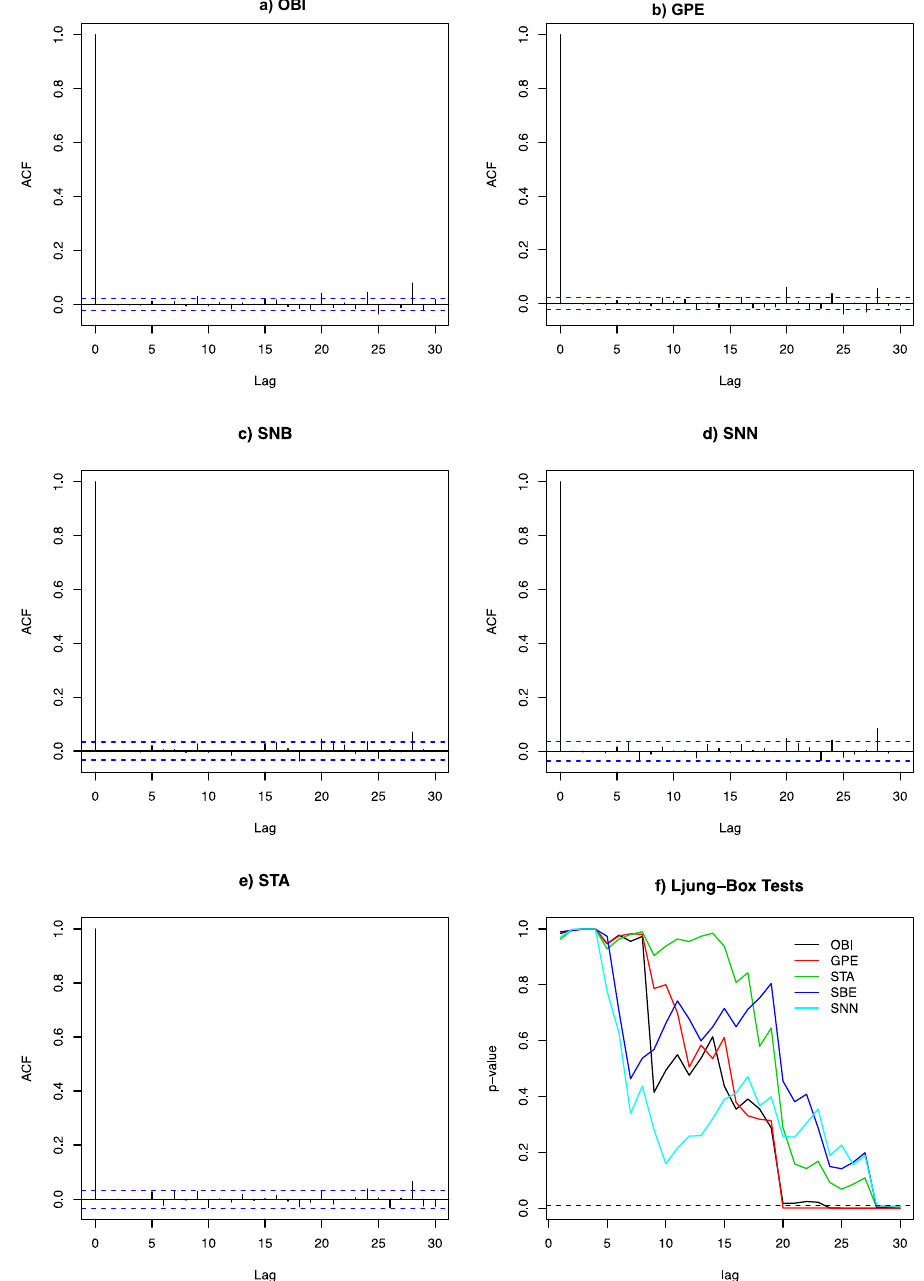
Figure 4. Residuals ACF (panels a – e ) and Ljung–Box tests (panel f ). Larger six-hour lags show